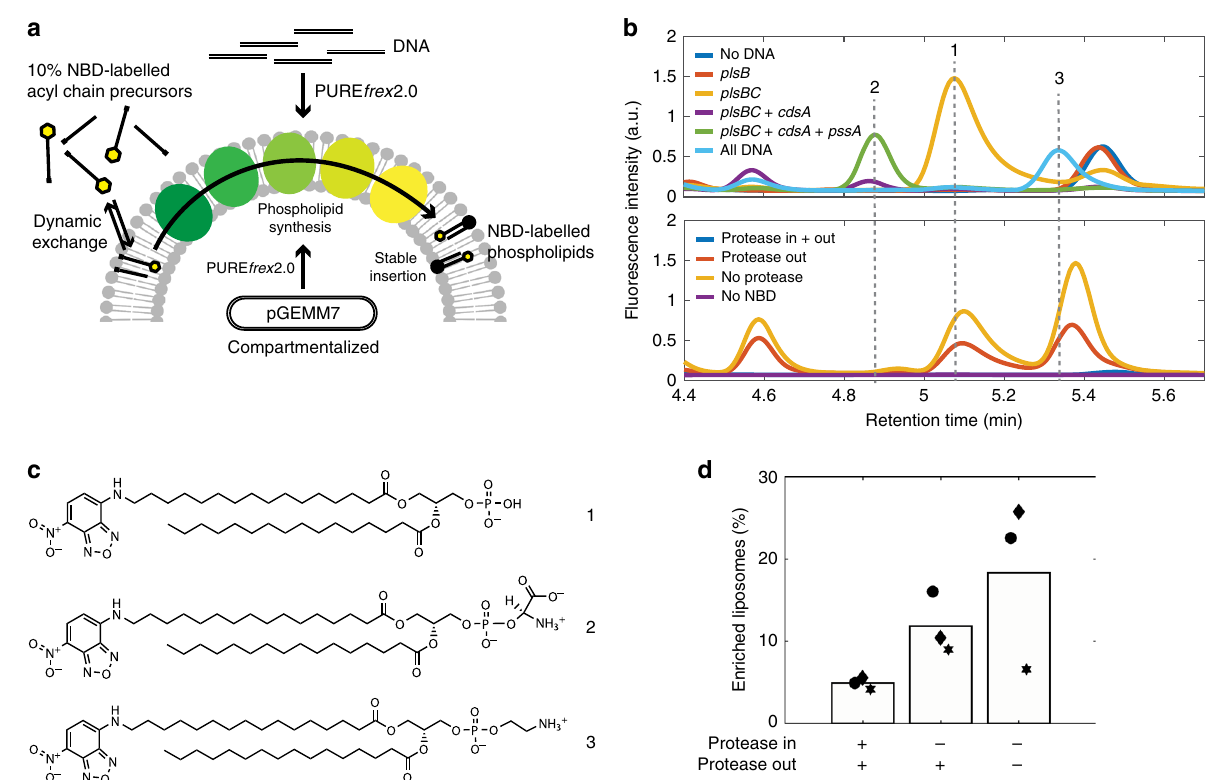
– –Protease Fig. 4 Cell-free biosynthesis of NBD-labelled phospholipids. a Schematic illustration of the conversion of NBD-labelled acyl chain precursors into newly synthesized membrane-bound phospholipids. NBD-labelled acyl-CoA molecules undergo dynamic exchange between the membrane and the aqueous solution. Upon processing of the lipid precursors by the fi ve-enzyme pathway, membrane-stable NBD-labelled PE is formed and an increase in NBD fl uorescence at the liposome membrane is expected. Either PCR fragments of the individual genes or pGEMM7 were used as DNA templates and no SP6 RNAP was introduced. The precursor mix consisted of 10% (in mol) NBD-labelled palmitoyl-CoA and 90% palmitoyl-CoA. Cell-free gene expression was either performed outside LUVs or it was compartmentalised inside giant vesicles, as indicated. b HPLC chromatograms of NBD-conjugated species detected when single and multiple genes of the pathway are expressed in the presence of LUVs (top), and when pGEMM7 is expressed inside giant vesicles (bottom). The different gene combinations allowed us to assign peaks to speci fi c lipid end products. Clear peaks were found for NBD-labelled DPPA (peak 1, plsB and plsC ), NBD-labelled DPPS (peak 2, plsB, plsC, cdsA , and pssA ), and NBD-labelled DPPE (peak 3, plsB, plsC, cdsA, pssA , and psd , labelled ‘ all DNA ’ ) . In the giant vesicle assay (bottom), proteinase K was either added to the inside of liposomes (no lipid synthesis), to the outside of liposomes (lipid synthesis restricted to the liposome lumen), or it was omitted. NBD-labelled DPPA and NBD-labelled DPPE could be observed. c Chemical structures of NBD-labelled DPPA (1), NBD-labelled DPPS (2), and NBD-labelled DPPE (3). d Percentage of NBD-enriched liposomes, i.e. liposomes that successfully converted NBD-palmitoyl-CoA into two-acyl compounds, was calculated by analysing line pro fi les of single liposomes imaged by fl uorescence confocal microscopy (Supplementary Fig. 11). Conditions correspond to the giant vesicle experiment shown in ( b ) (bottom). The samples were washed three times to remove non-reacted NBD-palmitoyl-CoA. Bars are mean values from three independent experiments. Symbols indicate data points from individual repeats. A total of 741, 613, and 505 line pro fi les were analysed (from left to right). Source data are available for (